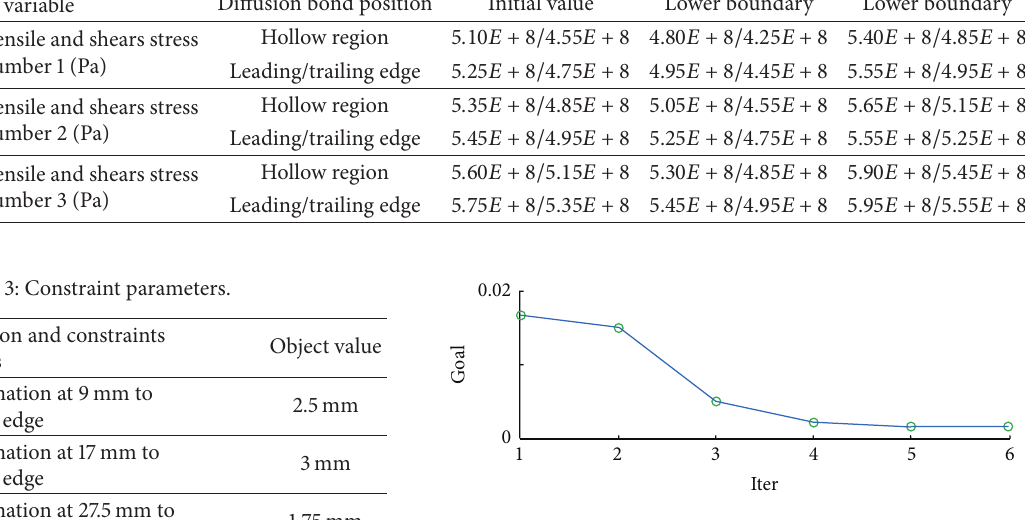
Figure 7: Optimization convergence curve.